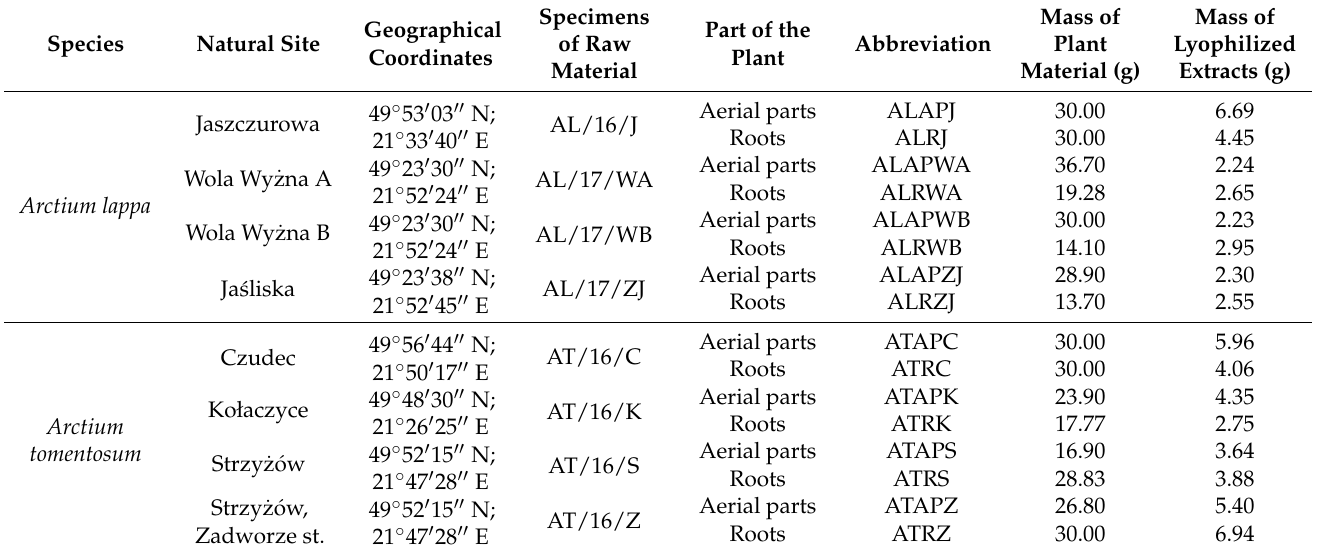
Table 1. Natural sites, geographical coordinates, specimens of raw material, abbreviations, and masses of powdered plant material and prepared 70% ( v/v ) ethanolic extracts.